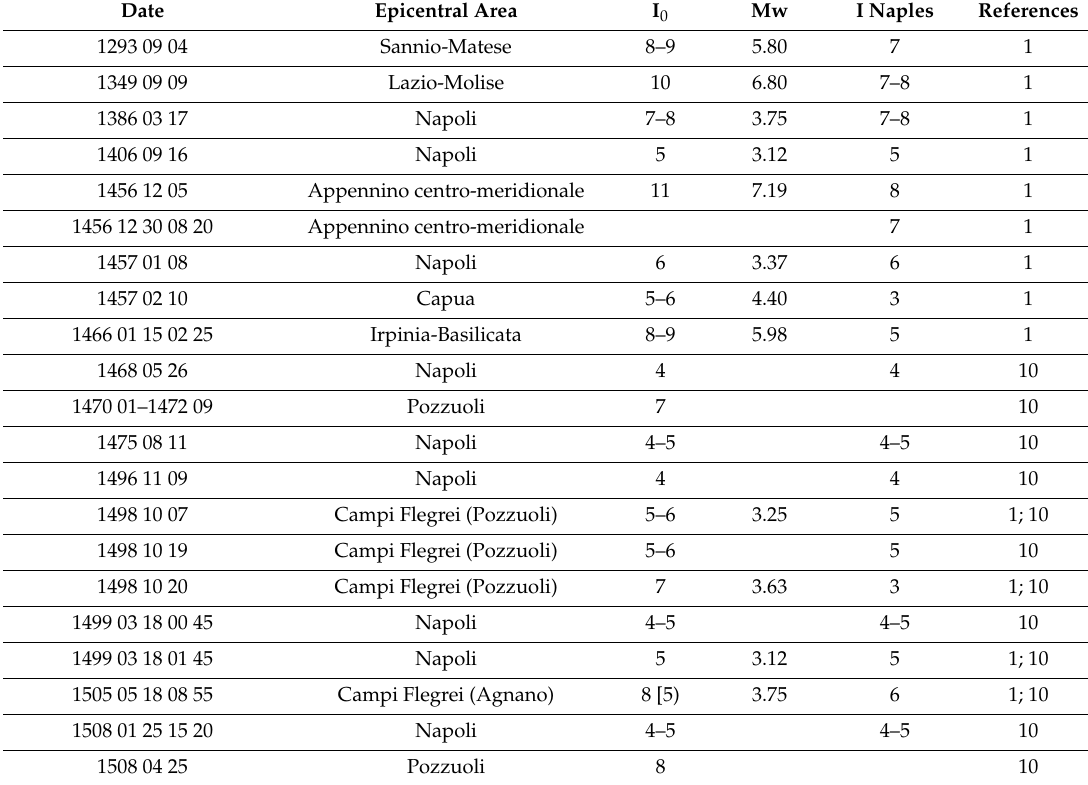
Table A1. The table contains the strong historical earthquakes of the Southern Apennines and the earthquakes of the Neapolitan volcanic areas that were a ff ected in the city of Naples [1, 8, 9, 10, 12]. Epicentral